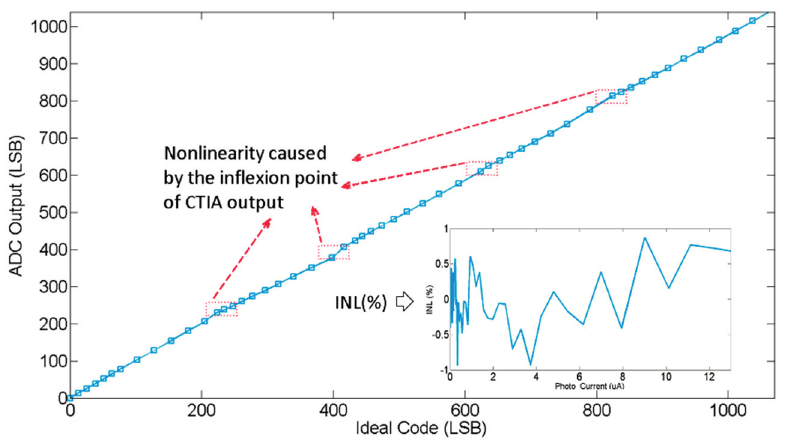
Figure 18. The linearity of the proposed image